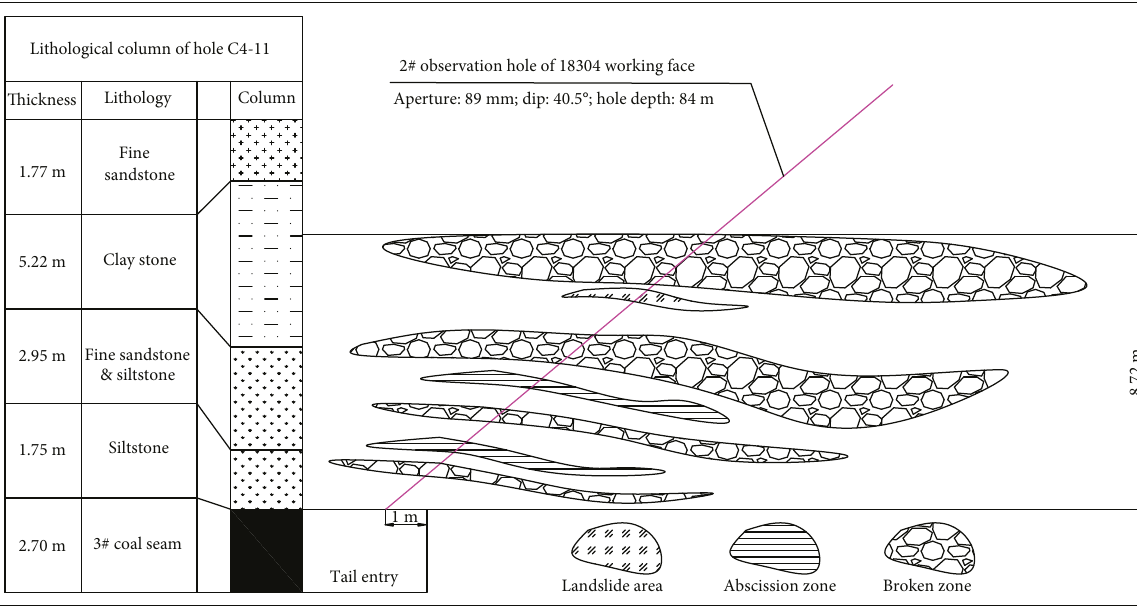
Figure 13: Post-mining distribution of strata failure on the 183upper04 working face.